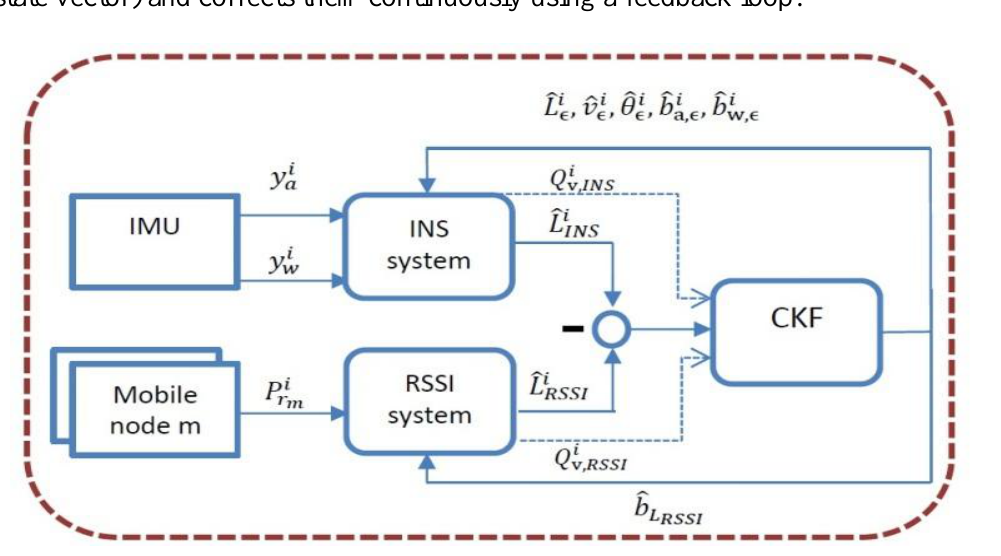
Figure 2. An implementation scheme of the CKF for tracking the m’th mobile node. It uses two independent estimations of location, each with different accuracies and error